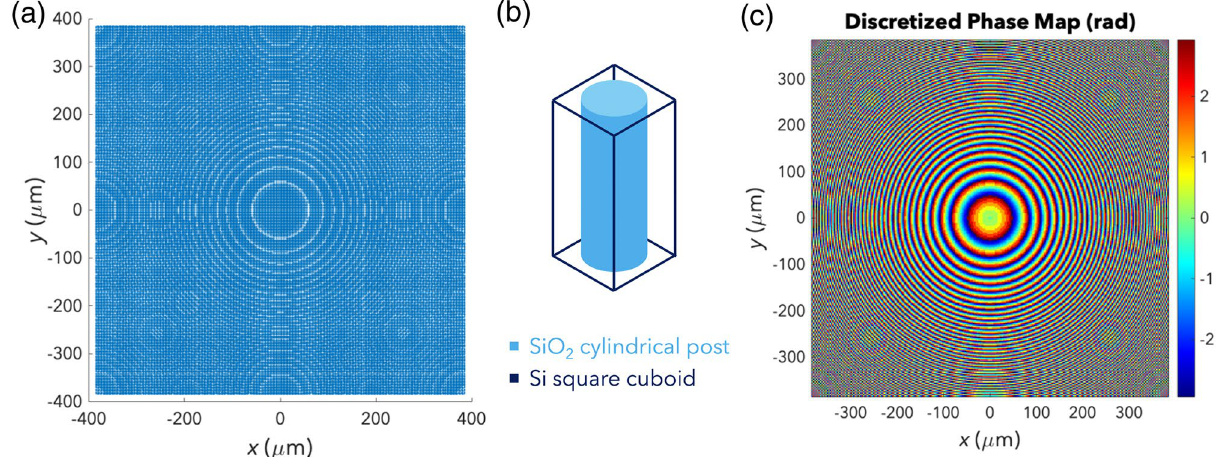
Figure 2. Ultrasonic metalens. ( a ) Top view of the ultrasonic metalens. ( b ) Unit cell made up of a SiO 2 cylindrical post (light blue) embedded in a Si square cuboid (dark blue). ( c ) Discretized phase map of the